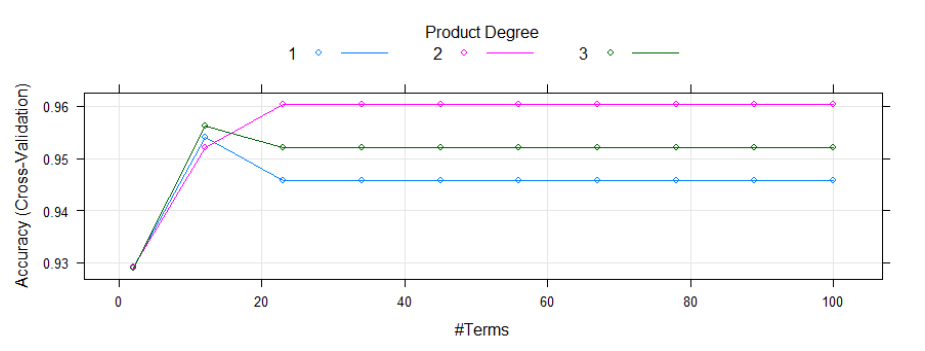
Figure 17. Selecting the number of components by CV for the breast cancer data.